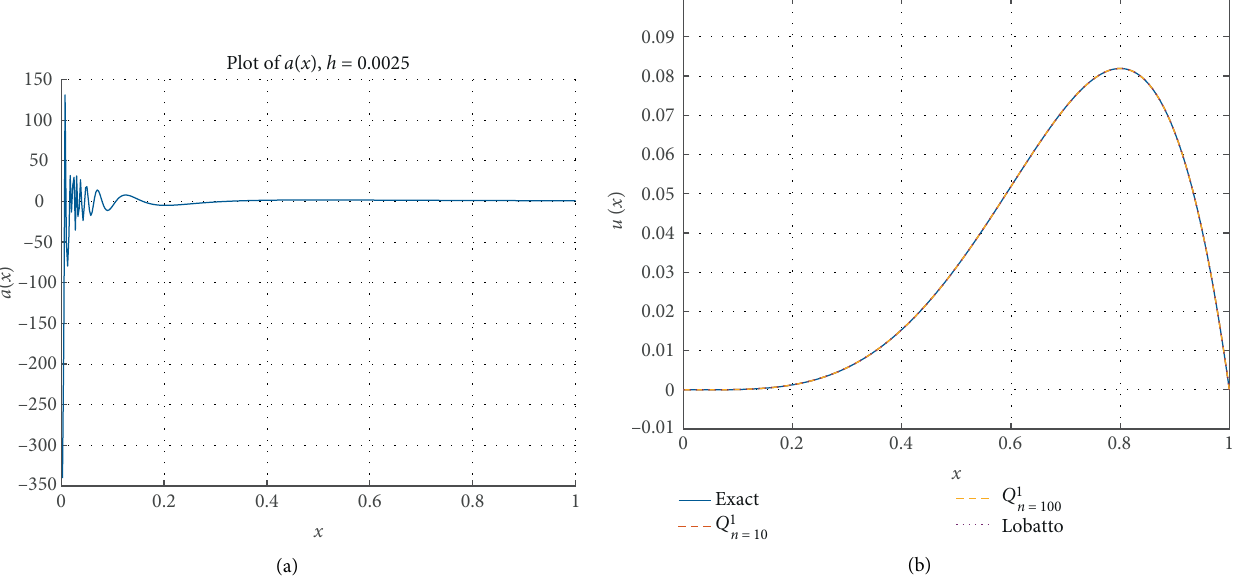
Table 6: Relative error for different values of